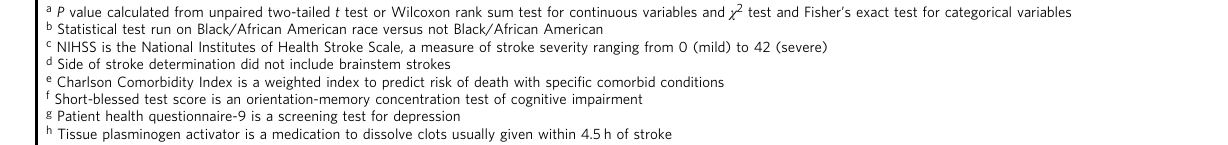
(Table 2), unadjusted analysis con fi rmed signi fi cant differences in network structure. Slow arrivers had smaller networks (mean 5, interquartile range (IQR): 4 – 8) than fast arrivers (mean 8, IQR: